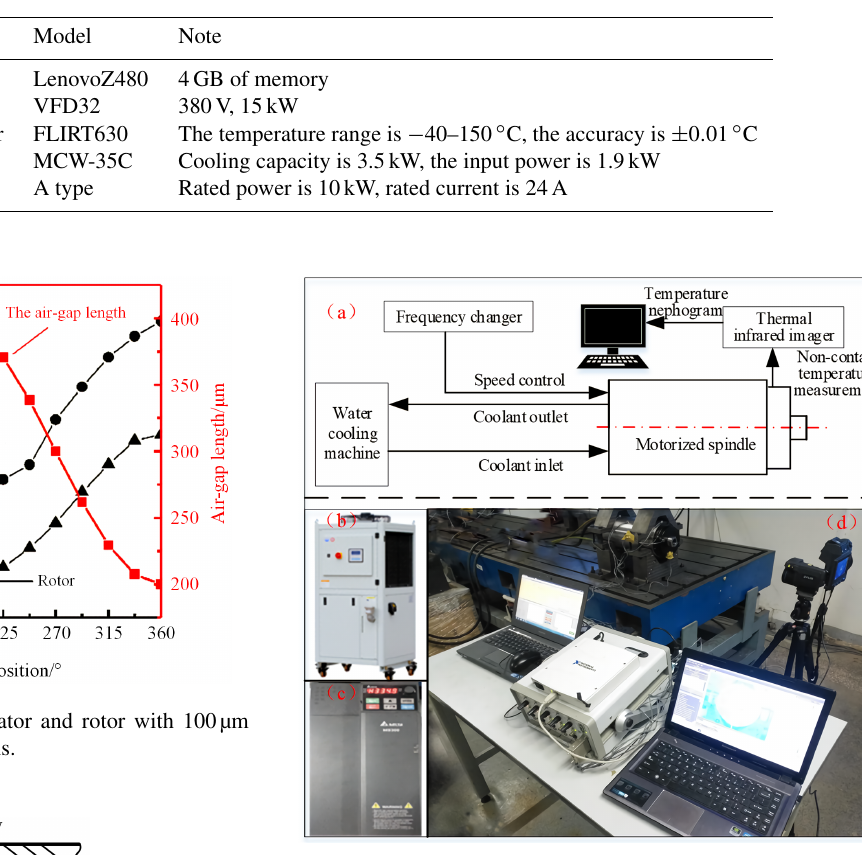
Figure 17. Experimental system principle and object diagram. (a) Schematic diagram of experimental design. (b) Water-cooling machine. (c) The inverter. (d) Experimental system structure dia-